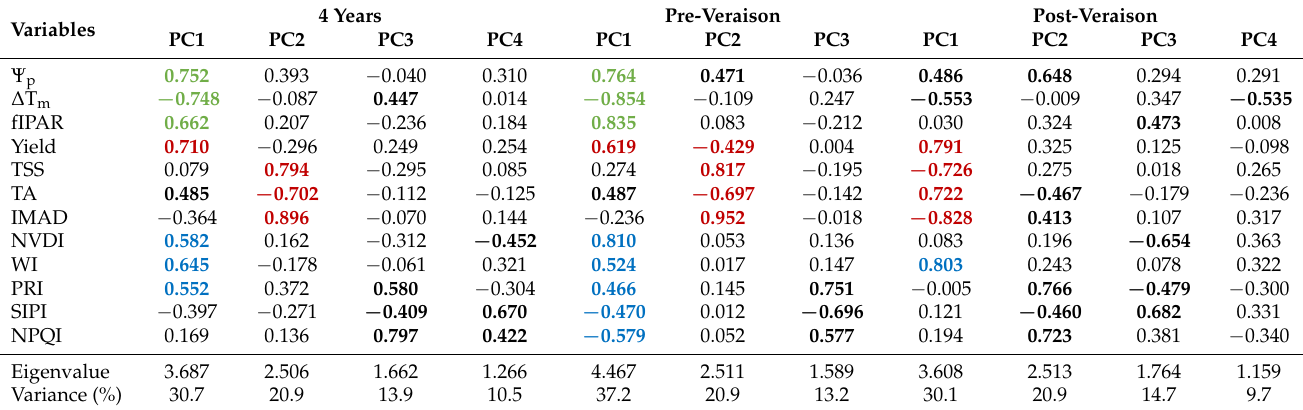
Table 6. Eigenvectors for measured vine vigour (fractional intercepted PAR, fIPAR), water status variables (predawn water potential, Ψ p ; and canopy to air temperature difference, ∆ T m ), berry yield and quality attributes (Total Soluble Solids, TSS; total titratable acidity, TA; and maturation index, IMAD) and reflectance indices (Normalized Difference Vegetation Index, NDVI; Water Index, WI; Photochemical Reflectance Index, PRI; Structural Independent Pigment Index, SIPI; and Normalized Phaeophytinization Index, NPQI). Principal Component Analysis results are shown for the whole data set (4 years, n = 101) and for separate sets considering the timing of occurrence of water deficits (pre- and post-veraison, n = 51 and n = 50, respectively). Bold characters indicate variables with large factor loadings. Vine biophysical attributes are highlighted in green, berry yield and quality attributes in red and reflectance indices in